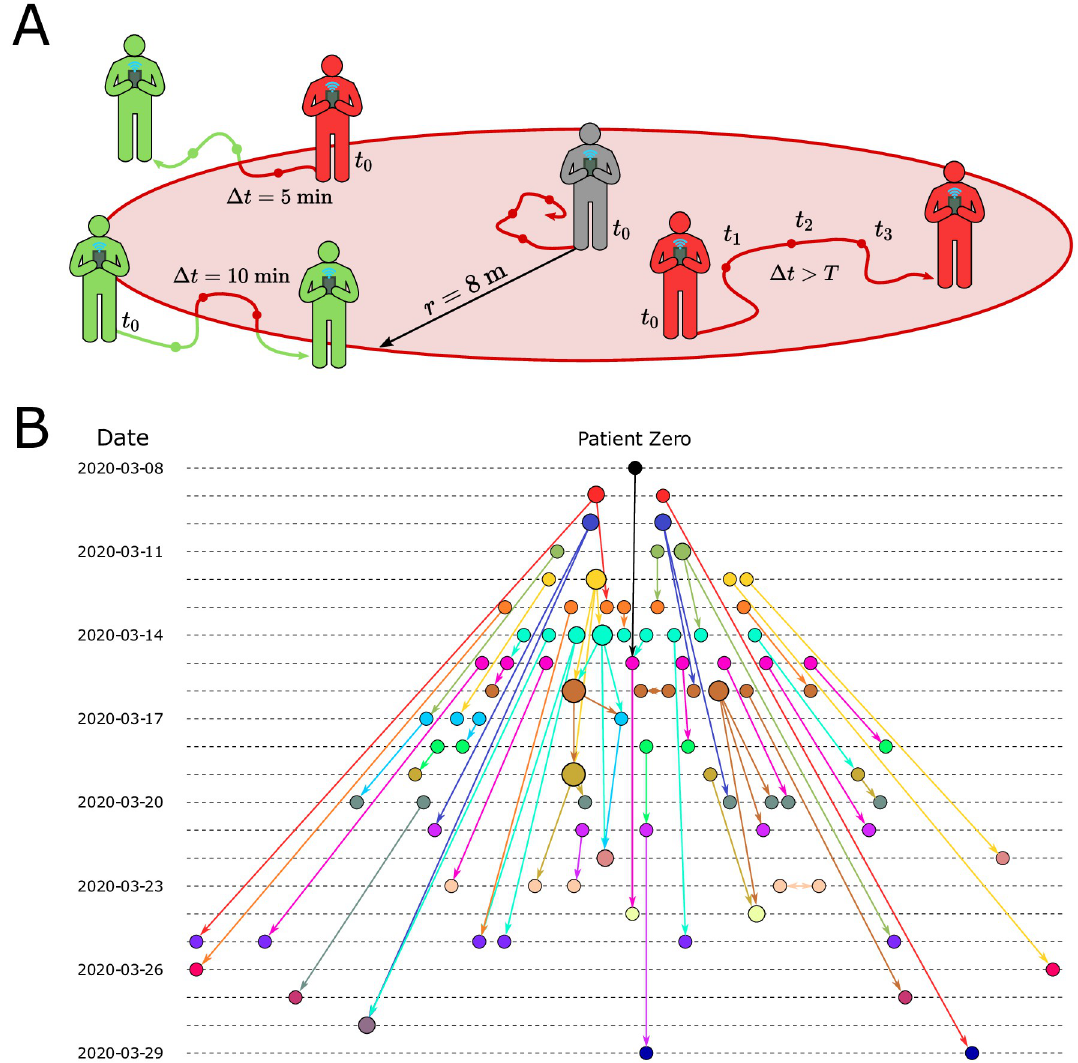
Fig 2. COVID-19 contact model. (A) Contact area used in the contact tracing model. The grey person is at the first datapoint of the source at t 0 . We collect all datapoints for every user in a T = 30 min forward window ( t 1 , t 2 , t 3 , ... , t 0 + T ) within an 8 m circle from the initial position. For each target (green and red) we compute the average position and the time spent inside the contact area (red part of the trajectory line). (B) Partial transmission tree of outbreak of confirmed SARS-CoV-2 infection identified by contact tracing during calibration in the month of March 2020. Links goes from the source of infection to the target. The colors represent the day of first symptoms for each node and size is the